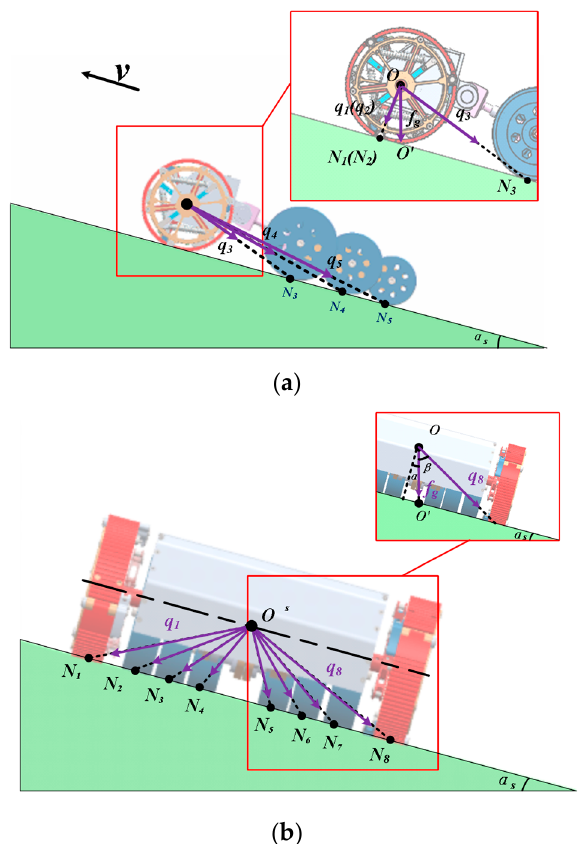
Figure 14. Analysis of robot slope motion based on the stable cone principle. ( a ) Lateral movement; ( b ) longitudinal movement.